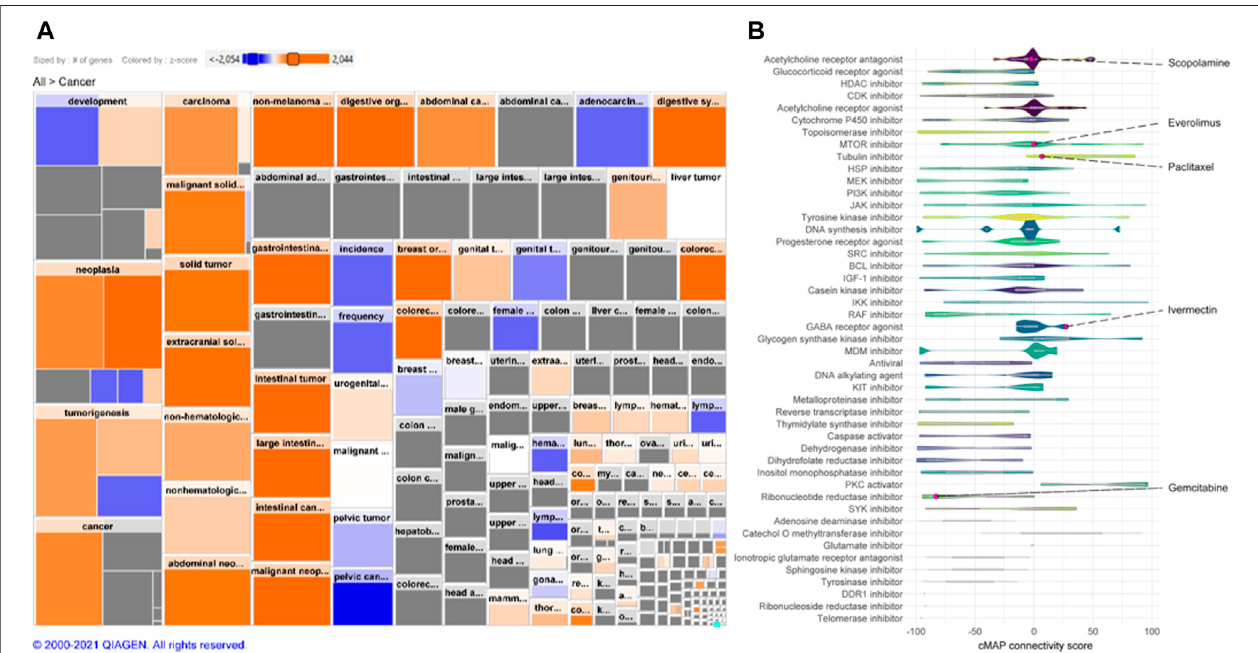
FIGURE2| Geneexpressionsignatureandconnectivitymap(cMAP). (A) HeatmapofhumanGCgeneexpressionsignaturethatconstitutesanactivationofcancer disease based on differential expression of > 22,000 genes. Size of square is proportional to the number of genes contained in the speci fi c function and color represent activity state ( z -score; orange: activated, blue: decreased). (B) Connectivity map (cMap) showing associations between a large-scale compendium of functional perturbations incancer cell lines coupled to thehuman GCgene expression signature based on the L1000 assay (Subramanian et al., 2017).Note: Ivermectin and other known drugs are